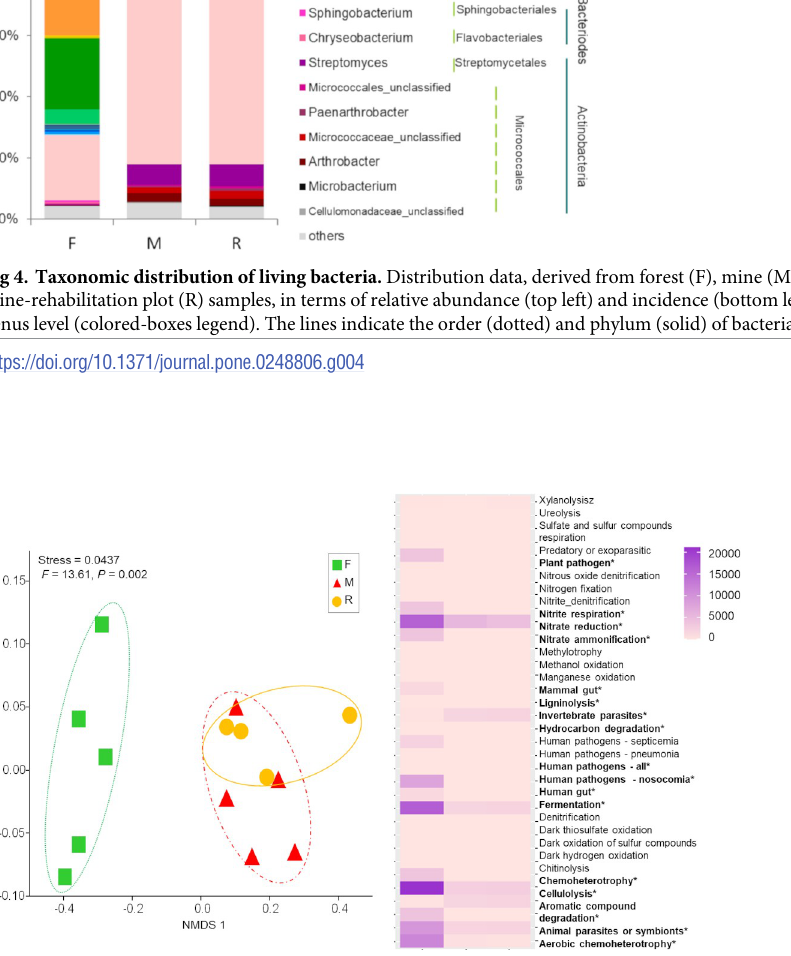
PLOS ONE | https://doi.org/10.1371/journal.pone.0248806 April 8,